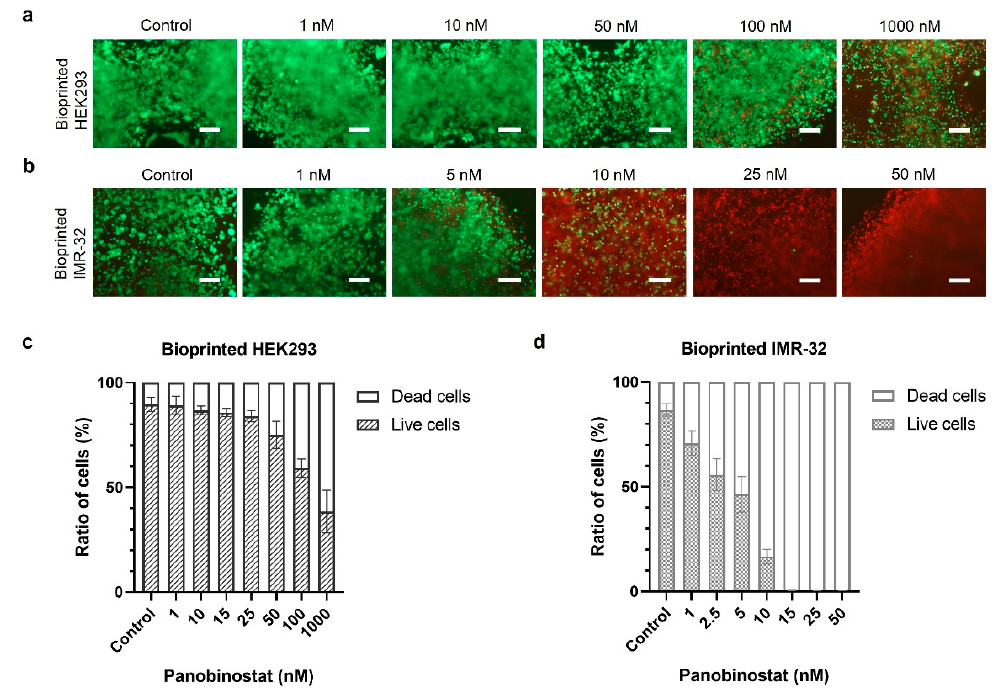
Figure 3. Cytotoxicity of HEK293 cells and IMR-32 cells in printed constructs after treatment with panobinostat. Cytotoxicity assays of 3D-bioprinted HEK293 cells ( a ) and IMR-32 cells ( b ) after treatment with panobinostat for 72 h (living cells in green, dead cells in red; all images were taken at the same magnification, scale bar, 250 µm), and the estimated percentages of living and dead cells ( c , d ).